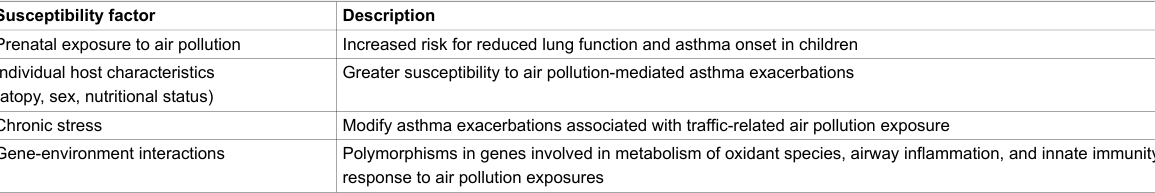
Table 1 Susceptibility factors identified in relation to childhood asthma as compiled in